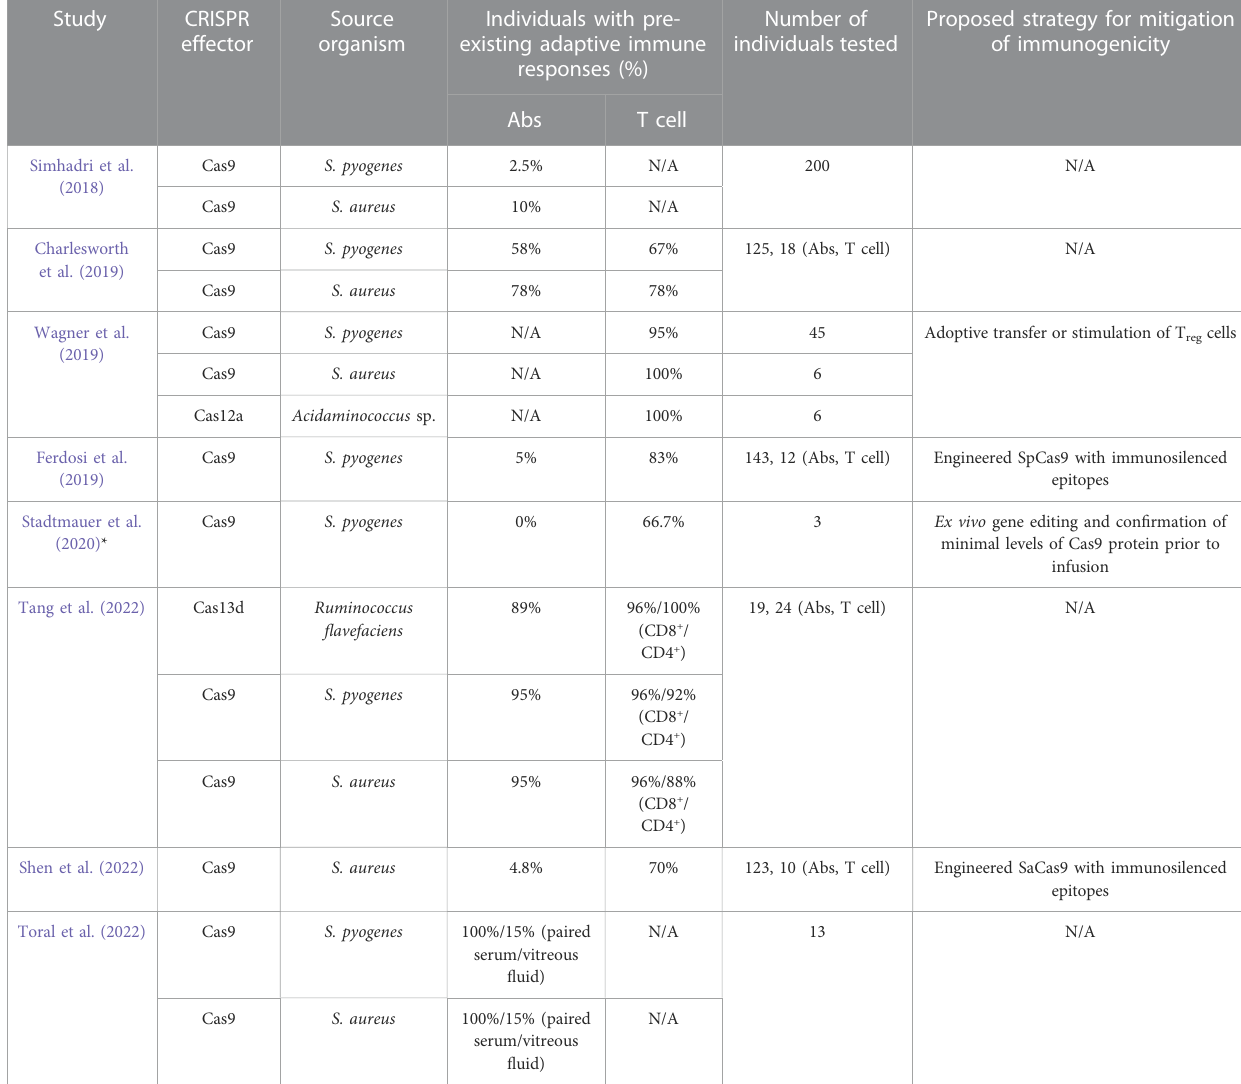
TABLE 1 Studies reporting pre-existing immunity to CRISPR effector proteins in healthy